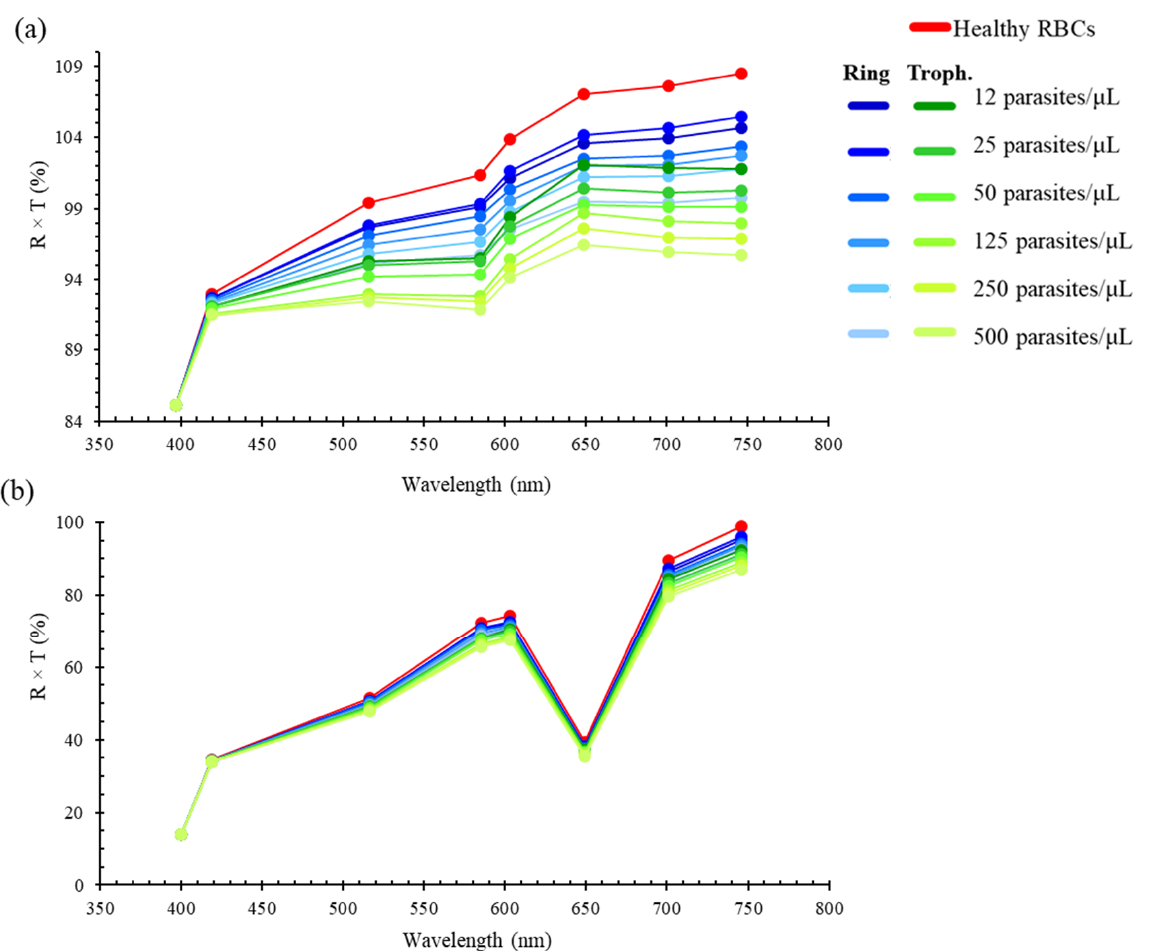
Figure 10. Reconstructed normalized optical reflectance spectra (%), based on 8 discrete wavelengths (represented by points in the plots), obtained from the combination between the transmittance spectra of the thin-film optical filters and the reflectance spectra of uninfected (red) and P. falciparum -infected RBCs samples (with different parasitaemia values, ranging from 12 to 500 parasites/μL of RBCs), in both early (blue, rings) and late (green, trophozoites) stages. ( a ) Numerical simulation; ( b ) experimental results.